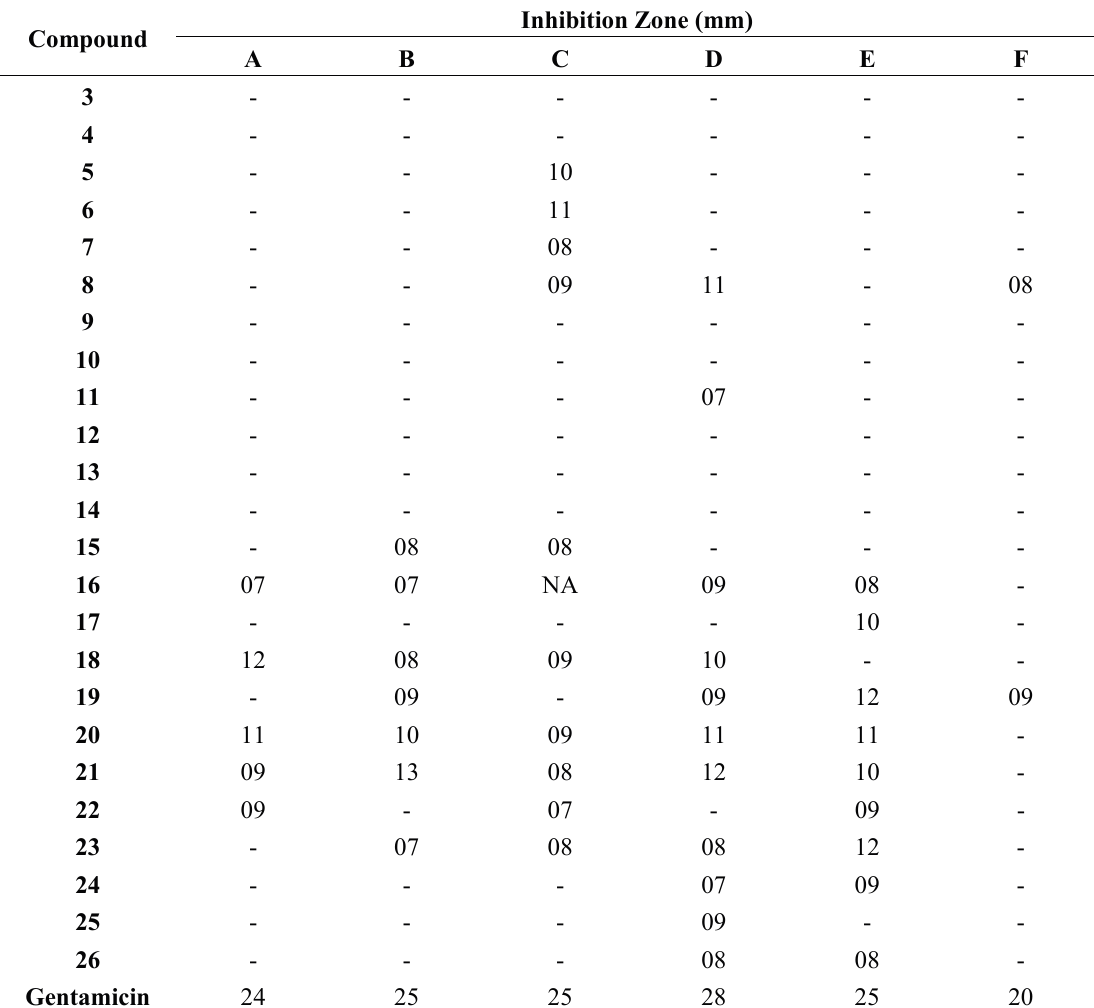
Table 4. Antibacterial activity of compounds 3 – 26 against Gram-positive bacteria (inhibition zones in mm using the disk diffusion